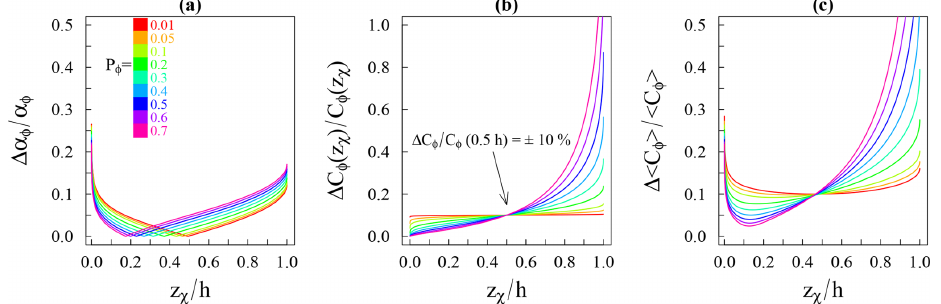
Figure 11. (a) Relative error of the predicted α φ according to the relative height z χ /h of the index sampling, for various Rouse numbers P φ . (b) Relative error of the concentration sampled, inferred from the Zagustin model and assuming error on (cid:104) C φ (cid:105) as a function of z χ /h